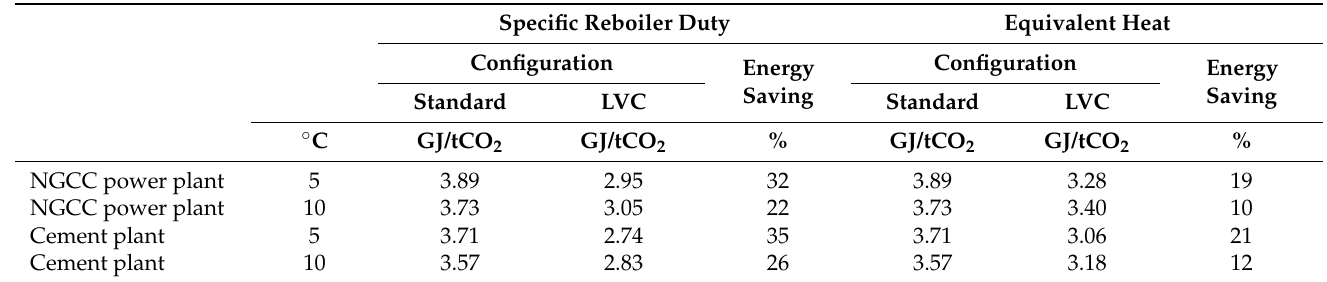
Table 14. Summary of energy performances of the standard and the LVC capture processes. Specific Reboiler Duty Equivalent Heat Configuration Energy Saving